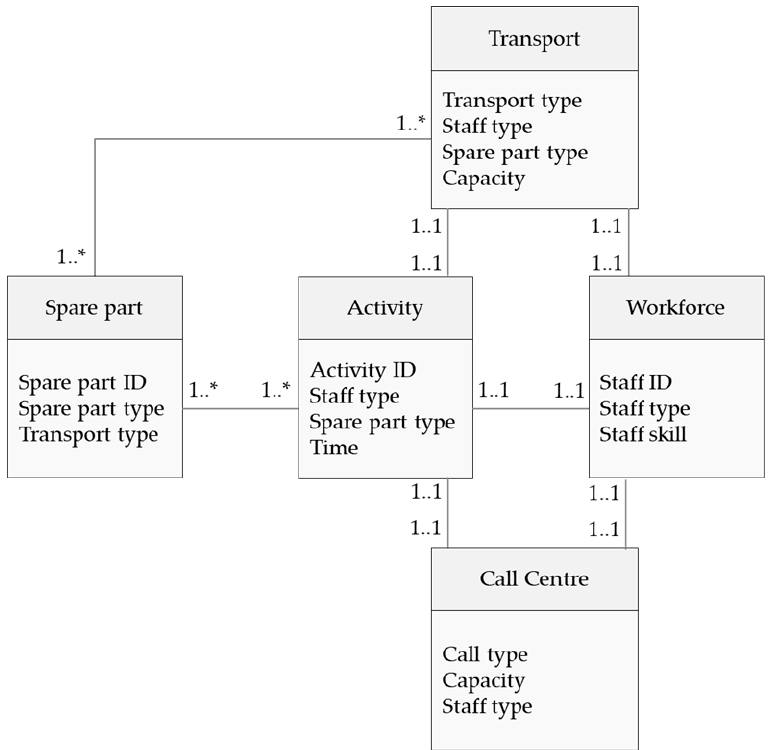
Figure 3. The Unified Modelling Language (UML) Class Diagram for the objects within the PBMS system.